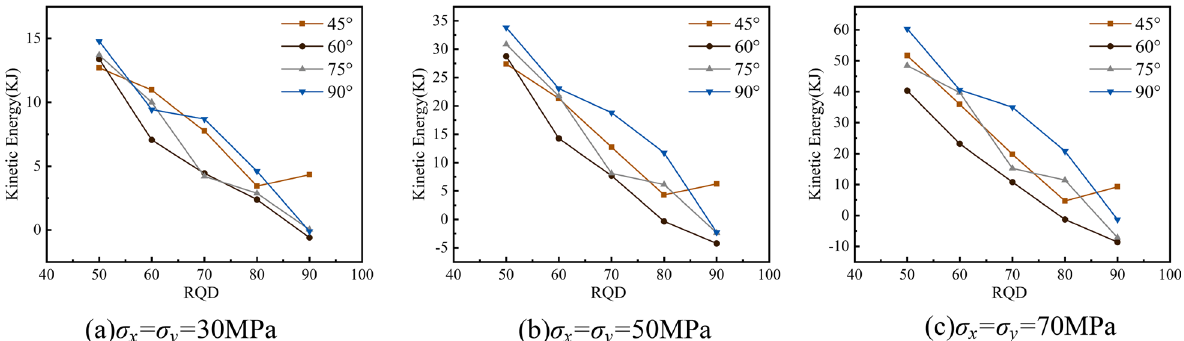
Fig. 16 KE' with different values of θ , RQD and in-situ